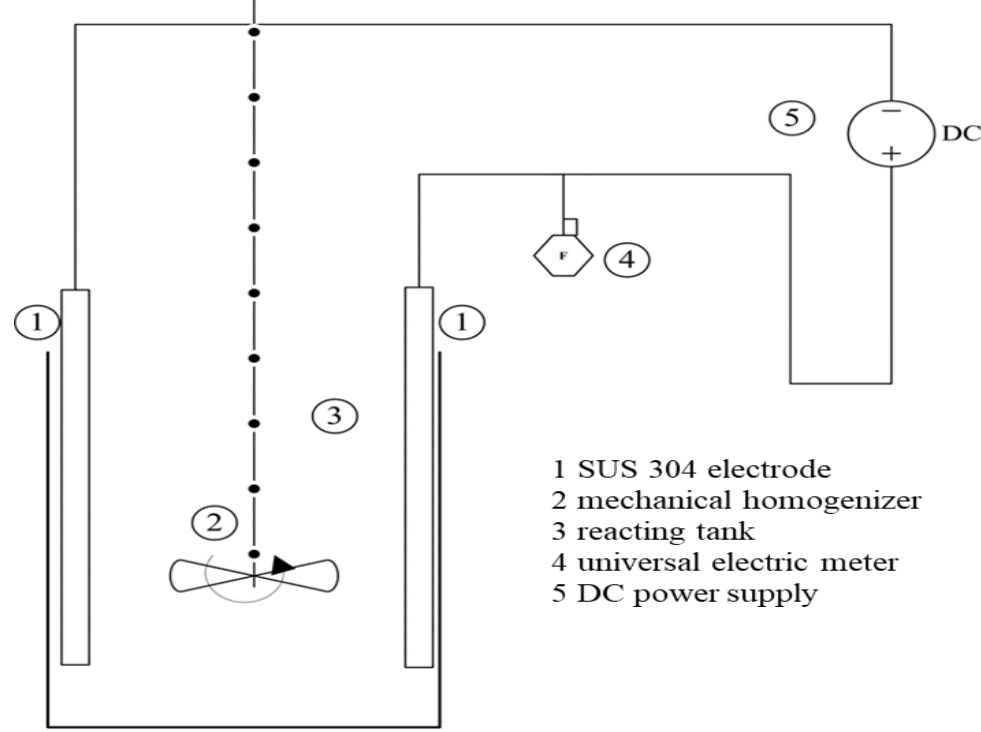
Figure 1. Experimental layout of water removal from reactant mixture by electrolytic dissociation during transesterification for biodiesel production.